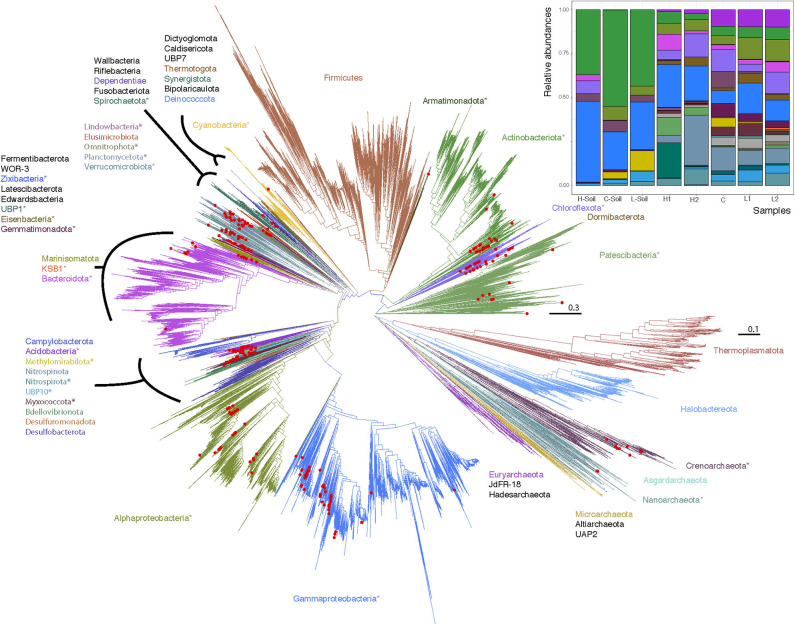
Maximum likelihood phylogenetic trees of Lake Hazen genomes based on 120 concatenated bacteria and 122 concatenated archaea protein-coding genes. Red Dots: Lake Hazen genomes. Asterisks (*) indicate phyla that contain Lake Hazen genomes. Bacteria tree is rooted with Patescibacteria and Archaea tree is rooted with Euryarchaeota. See GitHub account for full taxonomy tree files and for original tree files (Supplemental Data File 2 and 3) including the GTDB (v86) reference sequences (Parks et al., 2018). Inset shows MAG abundance across sites, in the 300 high quality genomes for each sample normalized to 100%.